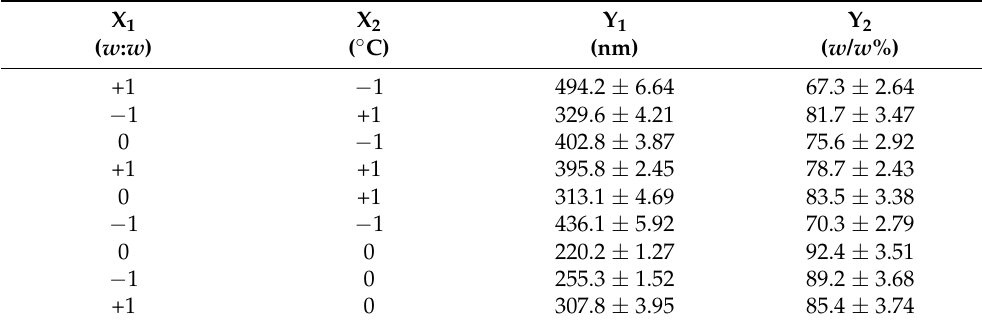
Table 1. Experimental design matrix of the full factorial design with experimental results. X 1 ( w : w